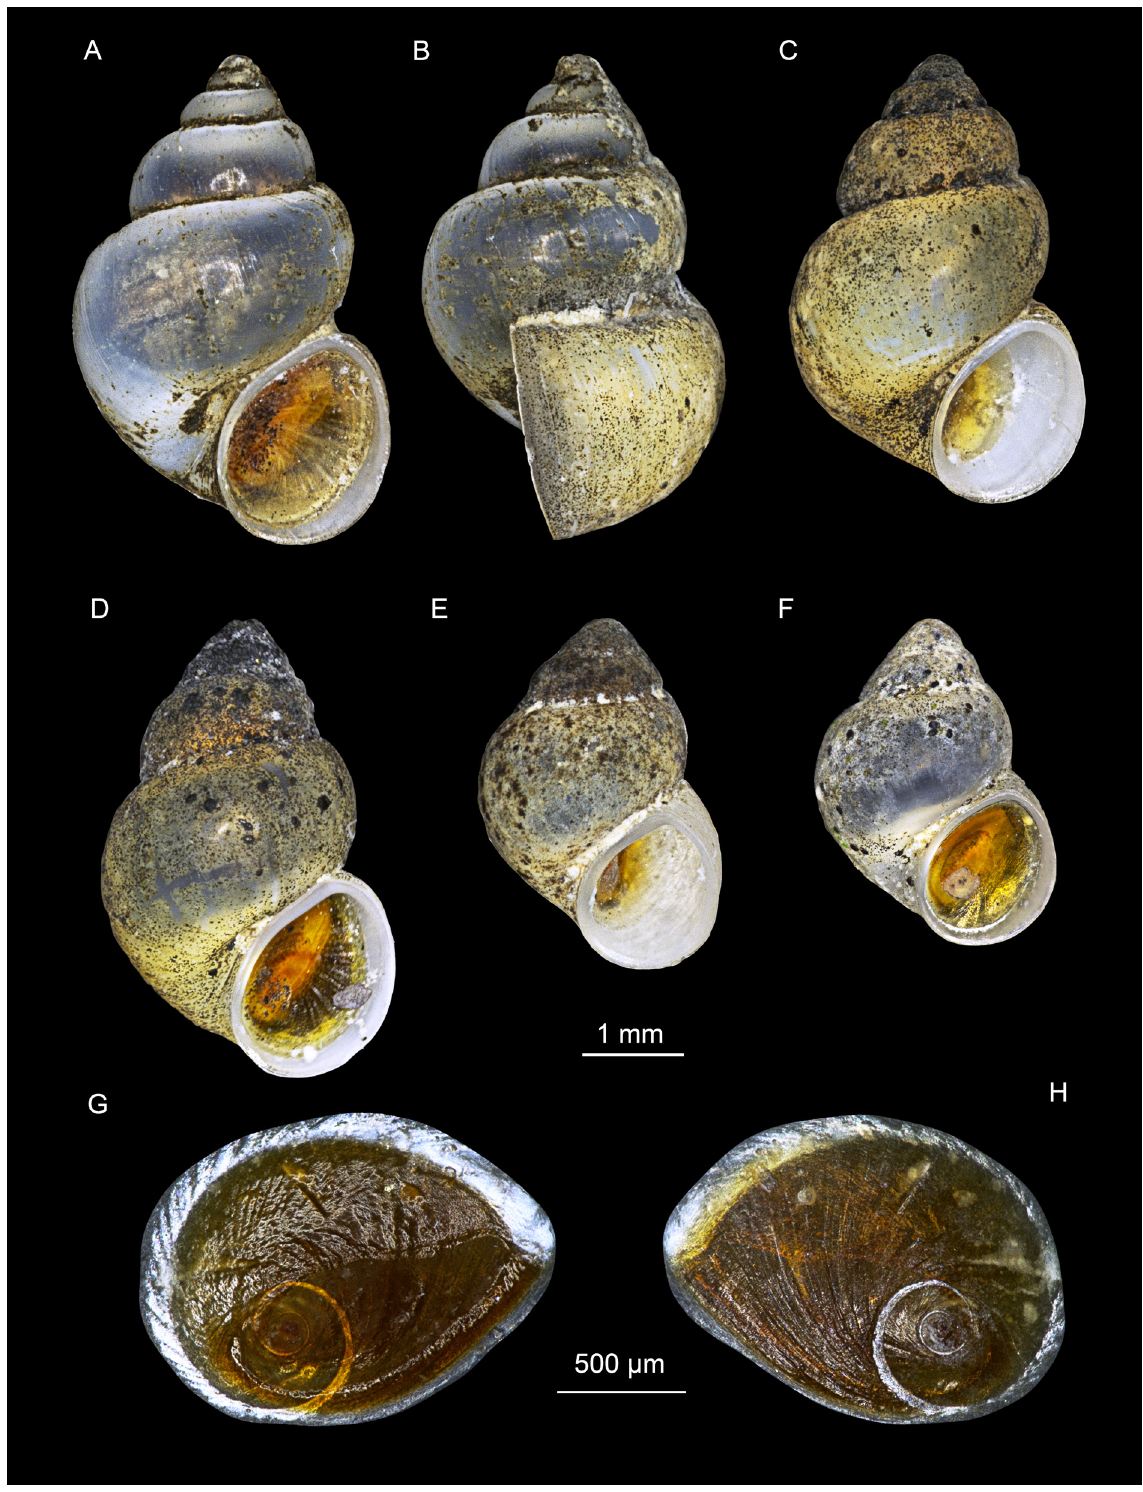
Fig. 29. Shells and operculum of Mercuria veronicae Miller, Khalloufi & Delicado sp. nov. A–B . Holotype (MNCN 15.05/200124H), frontal and lateral views. C–D . Paratypes. C . MNCN 15.05/200124P. D . UGSB 17271. A–D, G–H . El Waha Spring, Oasis Waterfall, Tamerza, Tozeur. E–F . Lekbir Spring, Big Waterfall, Tamerza, Tozeur. G . Operculum, inner side. H . Operculum, outer